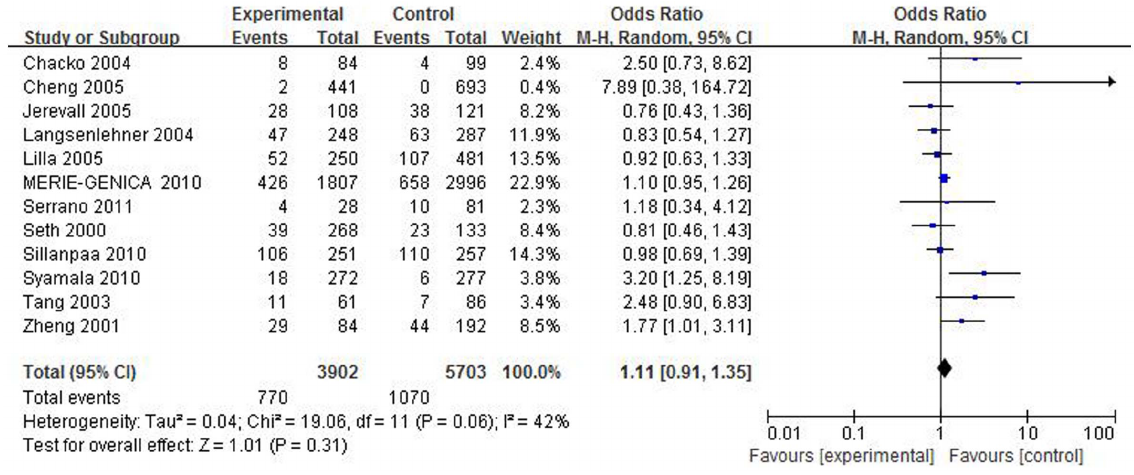
Figure 4. Forest plot on the association between SULT1A1 Arg213His polymorphism and breast cancer risk in homozygous model omitting Khvostova’s study.